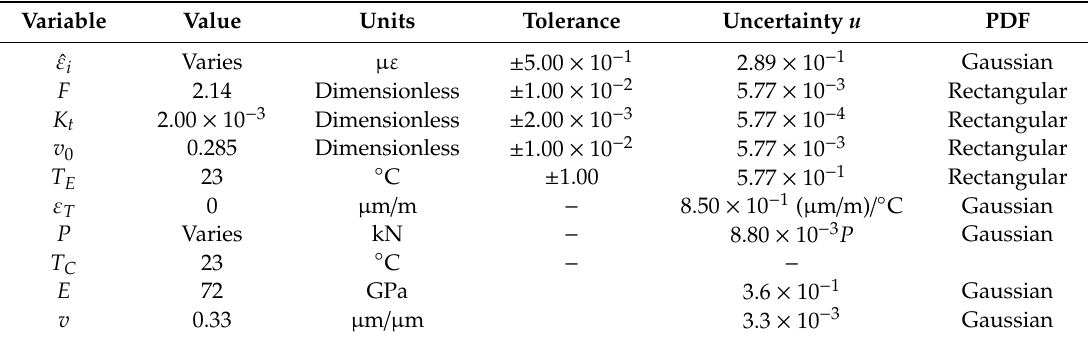
Table 3. Values, uncertainty and probability density functions of all the variables.